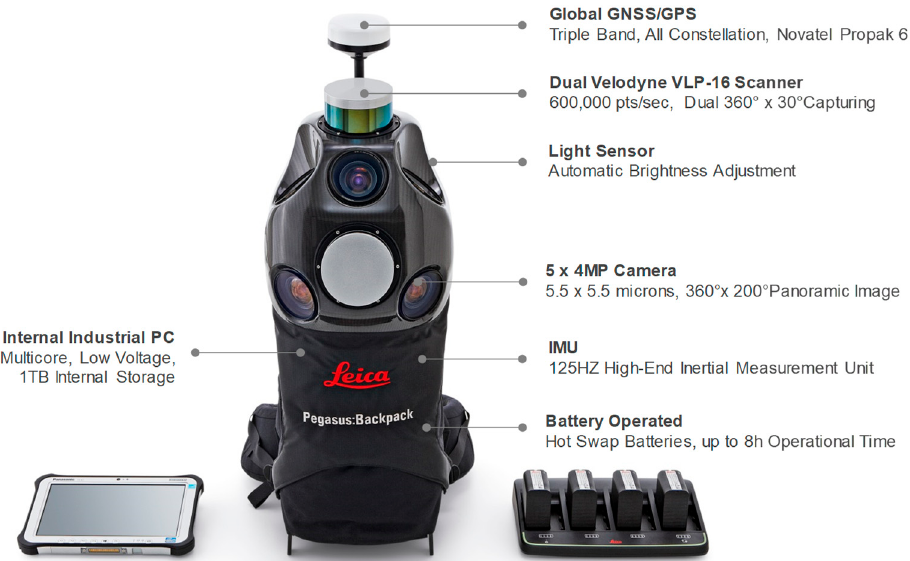
Figure 4. Leica Pegasus: External appearance of backpack (PB) (http://www.leica-geosystems.co.jp/jp/Leica-PegasusBackpack_106730.htm).